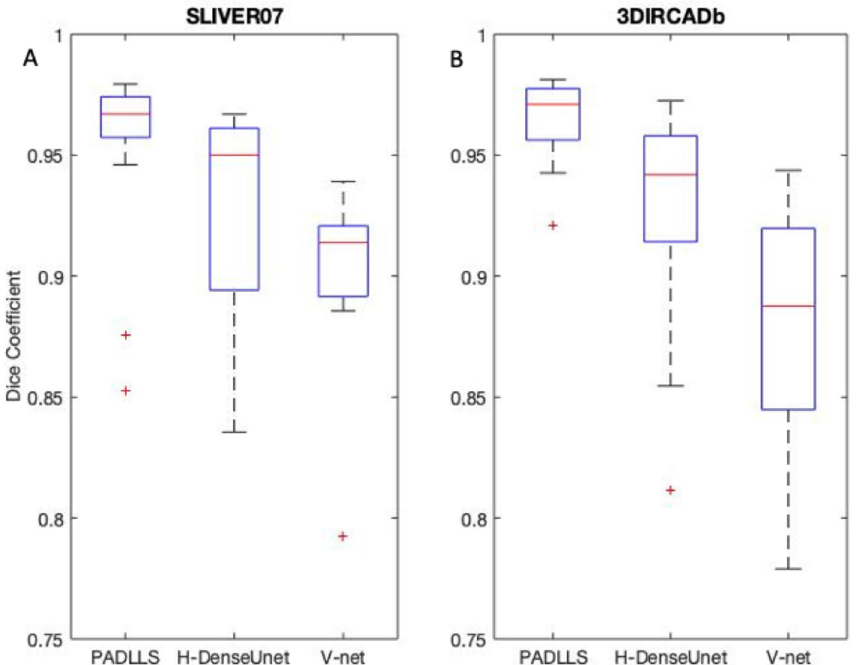
Figure 6. Statistical summary of the Dice coefficients for SLIVER07 ( A ) and 3DIRCADb ( B ) for our pipeline, H-DenseUnet, and V-net corresponding to left, middle, and right boxplots, respectively. Box and whisker plots with blue boxes showing the interquartile range, red line indicating the median, and red pluses indicating outliers. 3DIRCADb and SLIVER07 consist of 2823 and 4159 individual CT slices, respectively.